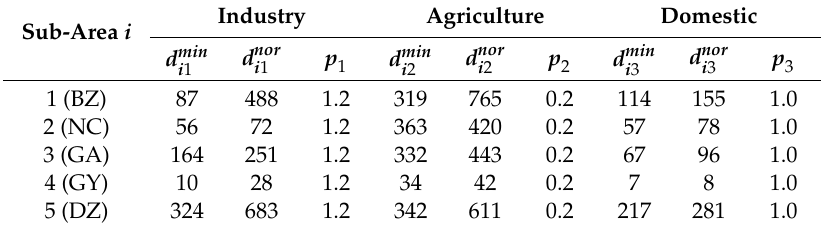
Table 3. Model parameters—requirement of water volumes and unit water costs.